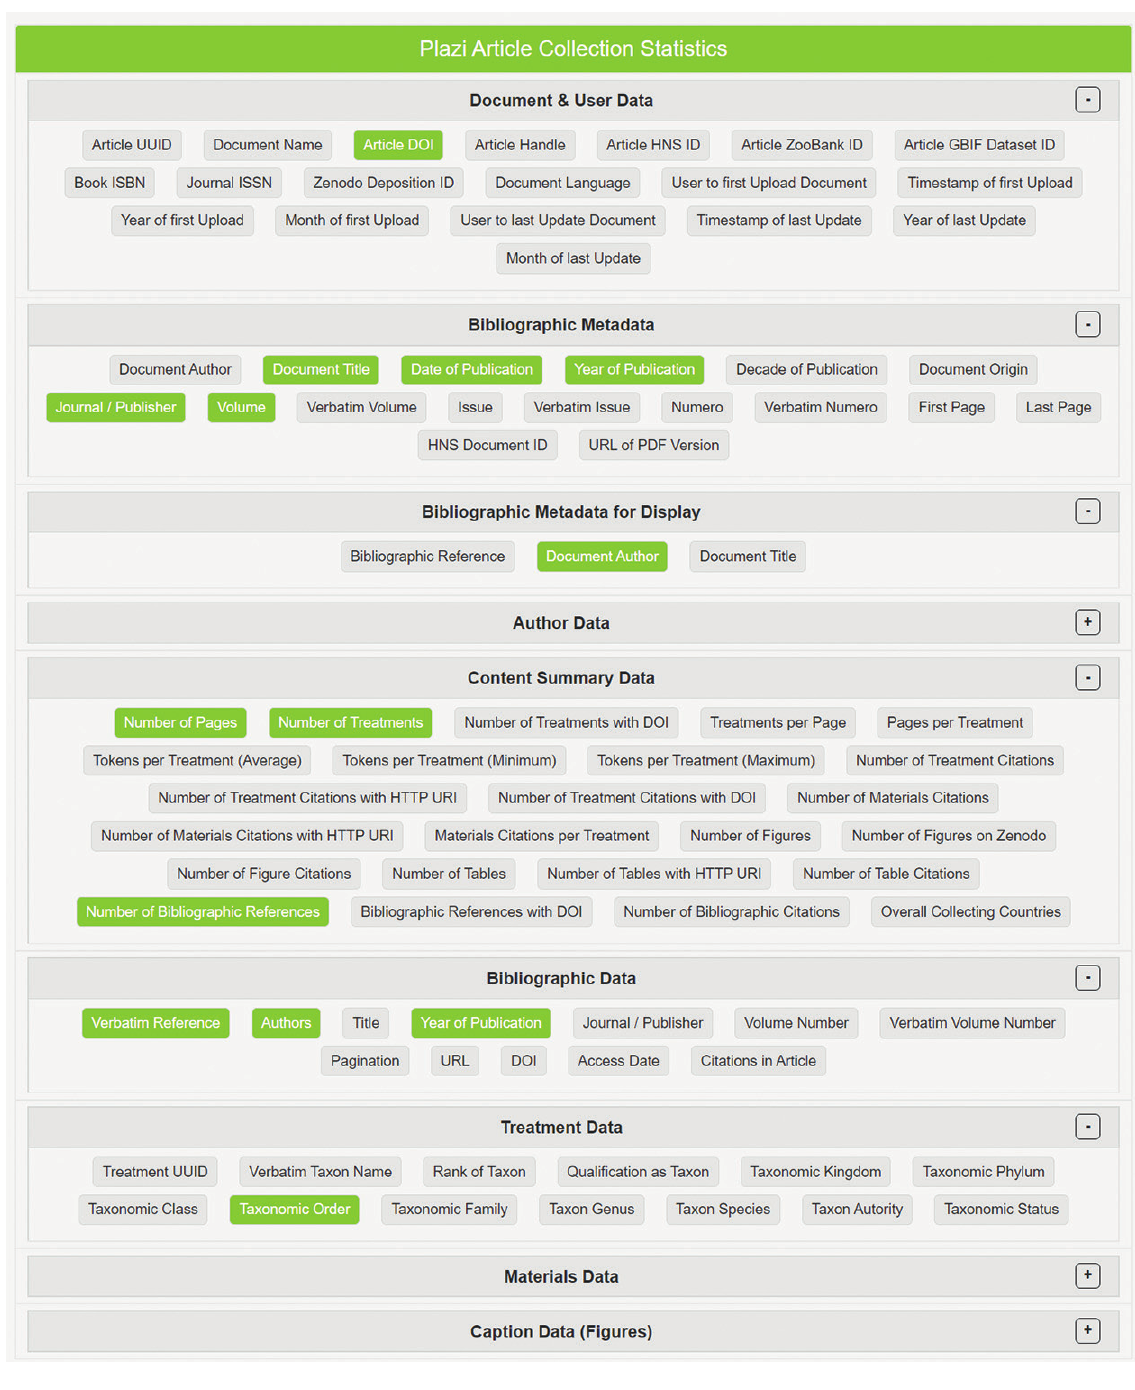
Fig. 2. Research within TreatmentBank’s Article Collection Statistics to extract the bibliographic references (source: